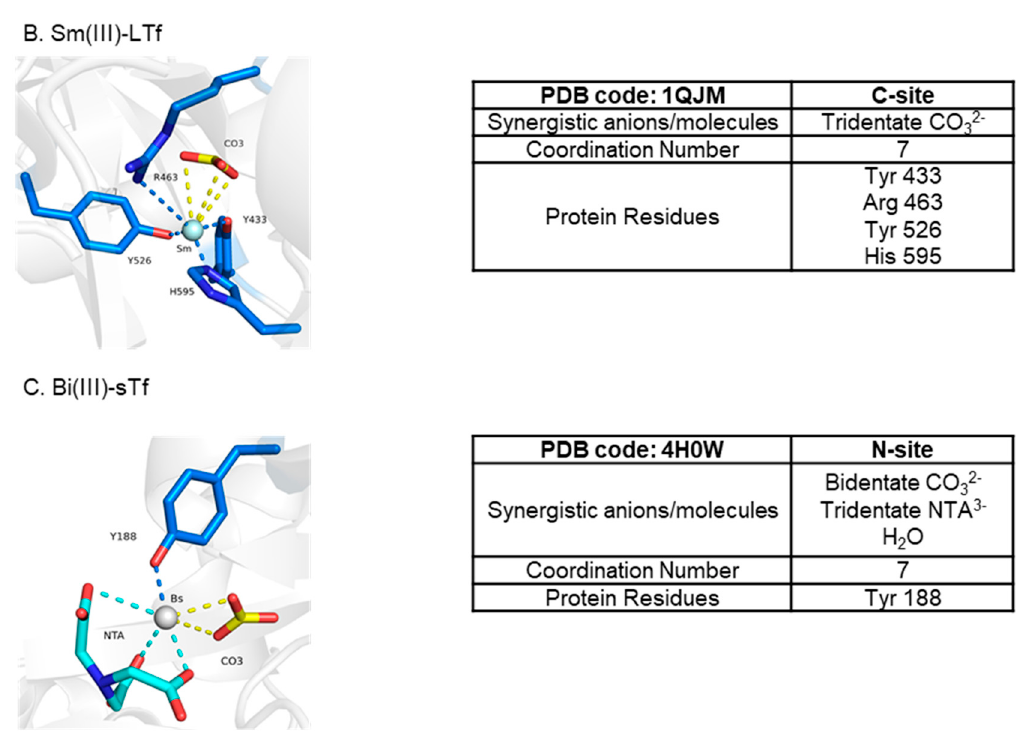
Figure 12. X-ray structures of sTf coordination of Cu(II) ( A ), Sm(III) ( B ), and Bi(III) ( C ) in noncanonical modality. Table 1. M n + -sTf a ffi nity and detection of M n + -sTf complexes with